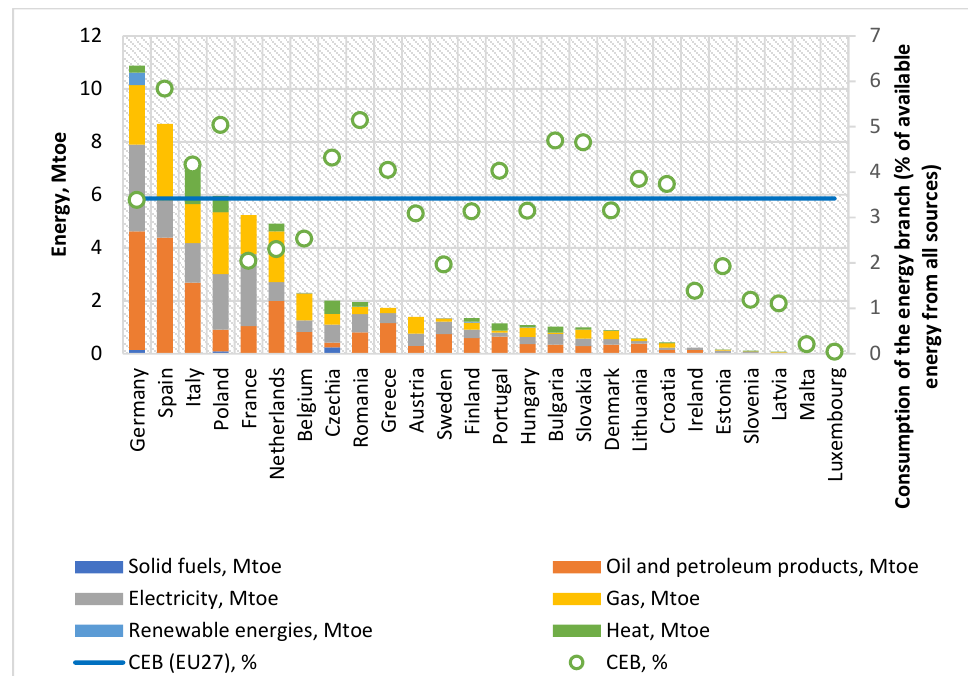
Figure 7. Consumption of the energy branch, 2020 (based on the Eurostat’s data (ec.europa.eu/eurostat/, accessed on 17 August 2022); © European Union, 1995 – 2022).